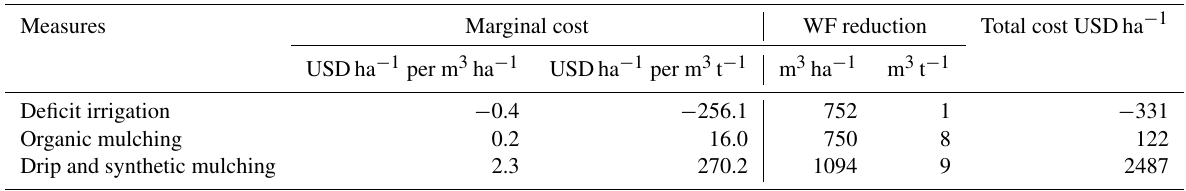
Table G3. Marginal cost and WF reduction per subsequent measure in the MCC for WF reduction in tomato production for the baseline of furrow irrigation combined with full irrigation and no